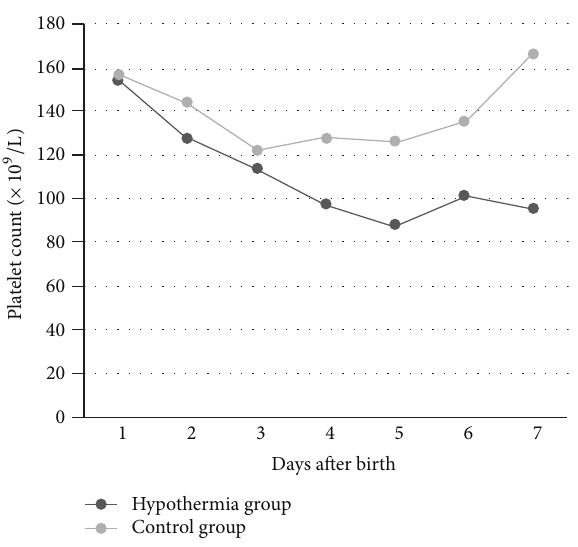
Figure 2: Mean platelet count during the first week after birth in our study population.